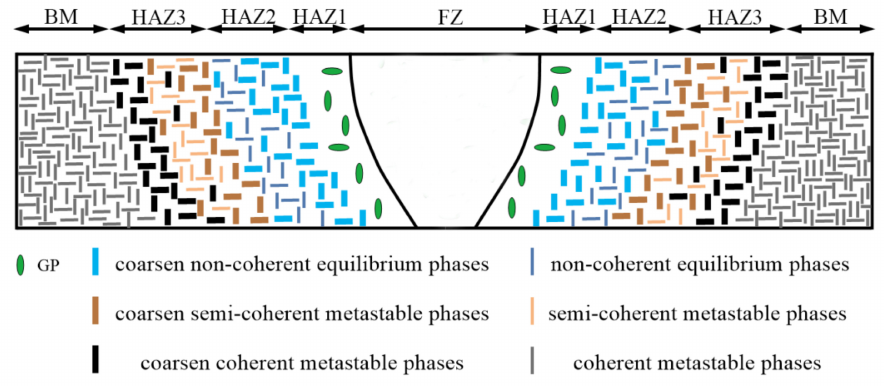
Figure 4. A schematic diagram of the evolution of the strengthening phases for a cross-section of a welded